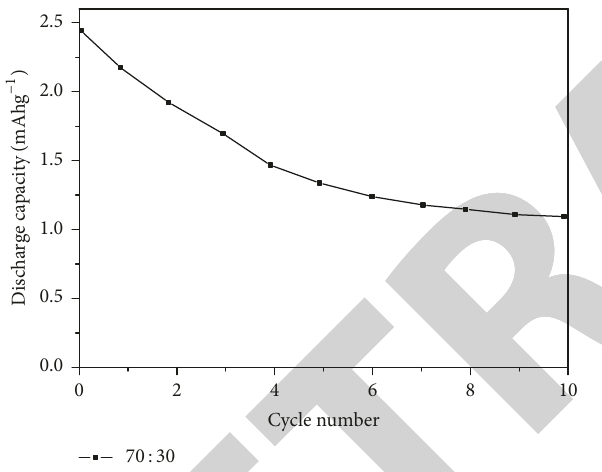
Figure 10: Variation of cycle number with discharge capacity of solid polymer electrolyte films for (70: 30)wt%